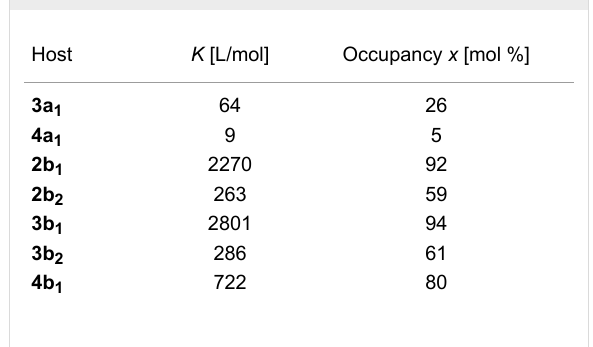
Table 3: Binding data for sevoflurane in the new CD thioethers at 25